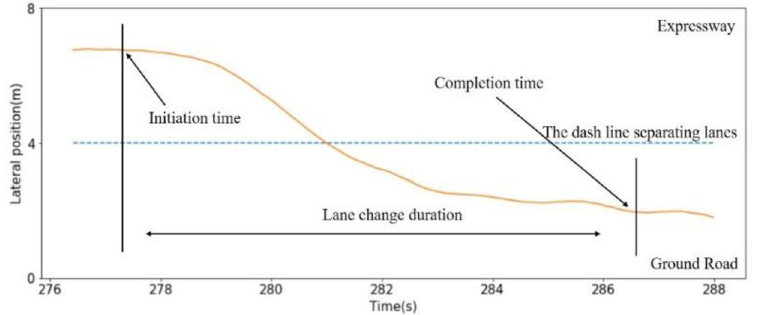
Fig 5. The initiation and completion points of lane-changing behavior.